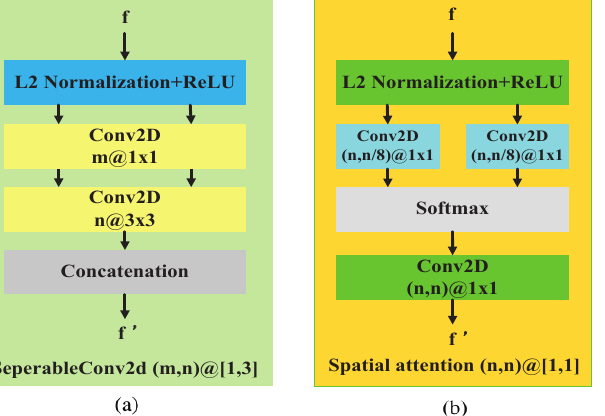
Figure 6. Depthwise separable convolution and spatial attention. ( a ) The structure of depthwise separable convolution and ( b ) spatial attention. “(m,n) @ [1,3]” denotes the depthwise separable convolution using 1 × 1 depthwise convolution for m times and 3 × 3 point convolution for n times. “(n, n) @ [1,1]” represents the number of input and output channels of convolution layers and “[1, 1]” means all convolution filters are size of 1 ×